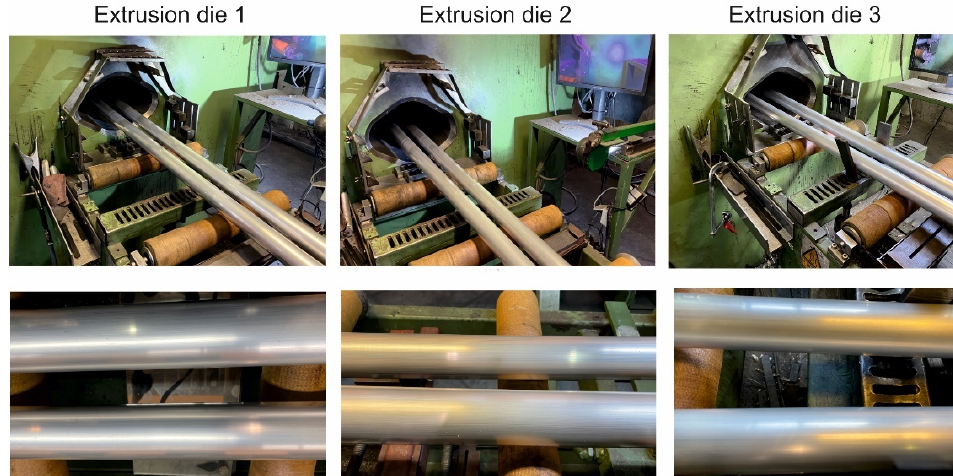
Figure 12. Extruded tubes of Ø50 × 2 mm from 7021 alloy on the press run-out table for dies of different geometry: die 1, T 0 = 480 °C, V 1 = 4.5 m/min; die 2, T 0 = 480 °C, V 1 = 3.5 m/min; die 3, T 0 = 480 °C, V 1 = 4.5 m/min.